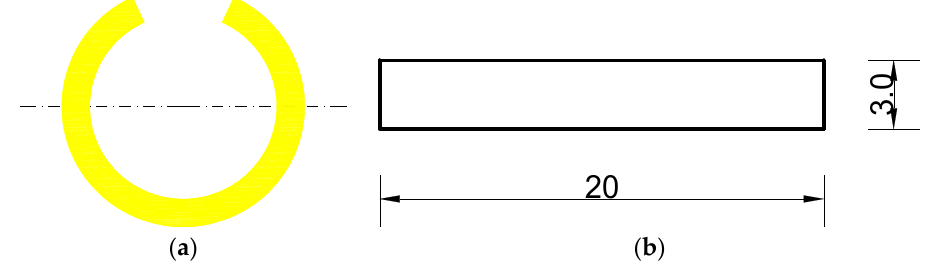
Figure 17. Substructure 5: damage size (unit: cm). ( a ) Damage section; ( b ) Hole size.